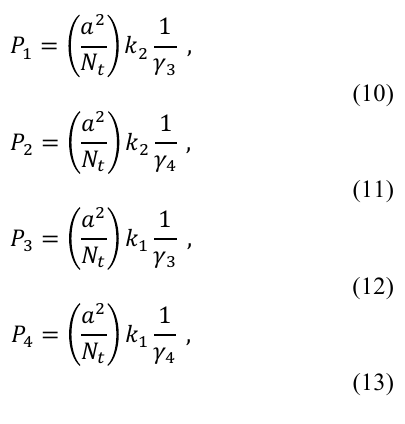
Figure 1. MIMO case: 4 users divided into 2 groups ( 𝑁 = 𝑁 = 2 ). Users 1 , 3 in 𝐺 ! ! Transmitted